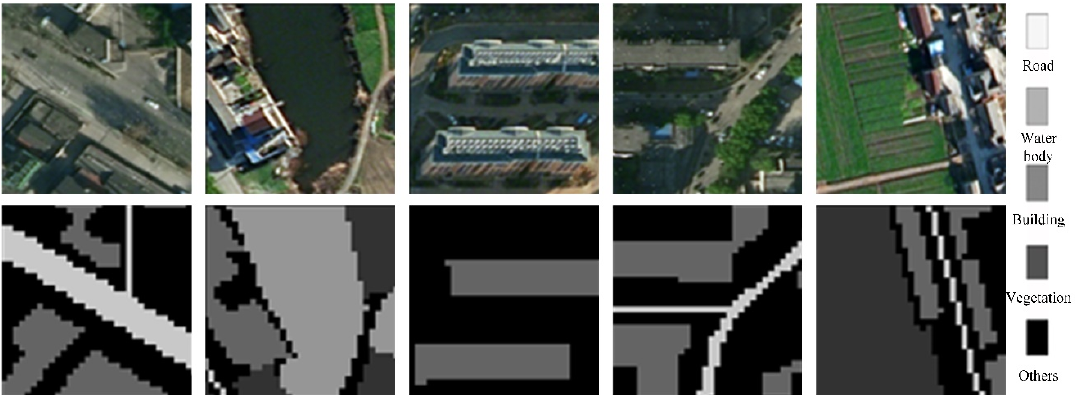
Figure 6. Part of the cutting images in the training set.